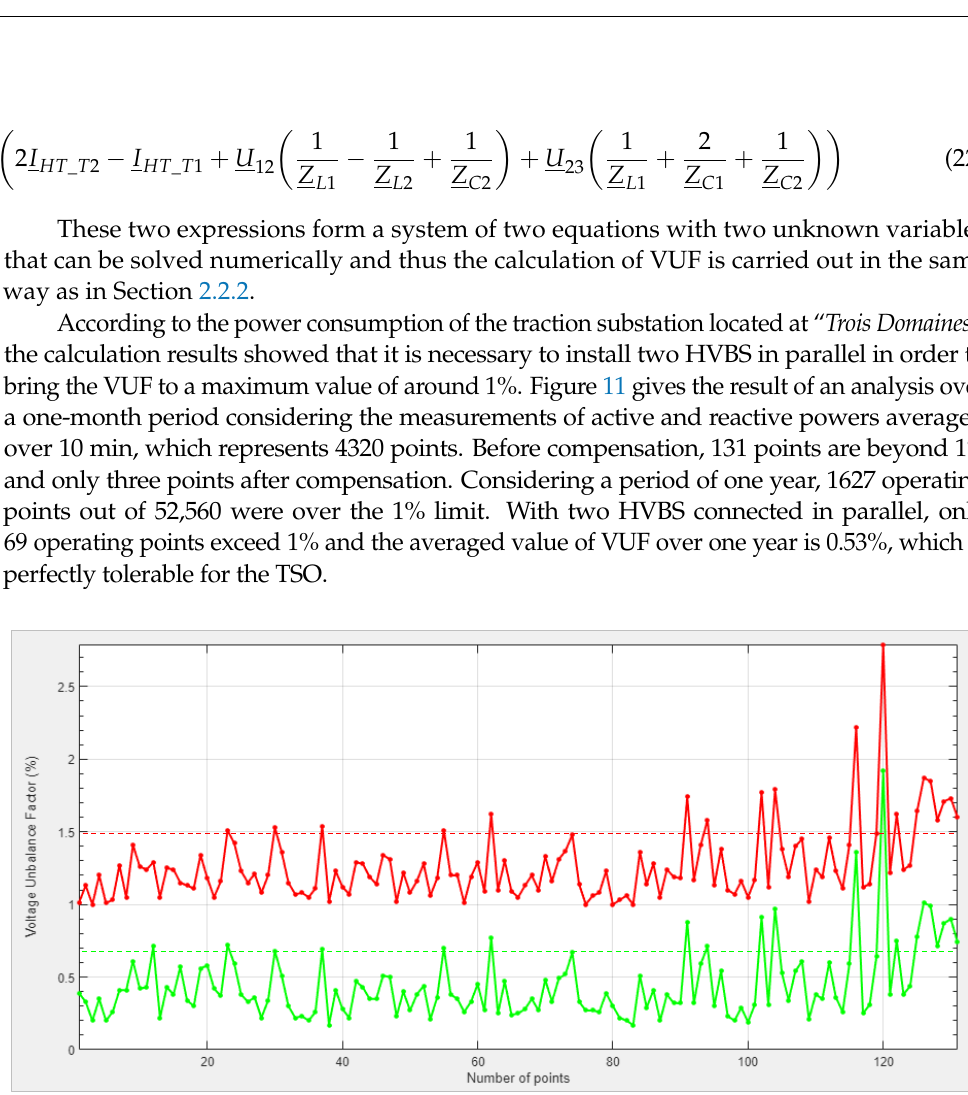
Figure 11. Data analysis over a one-month period: the red curve represents the voltage unbalance factor without compensation and the green curve represents the voltage unbalance factor with two Steinmetz active compensators connected.